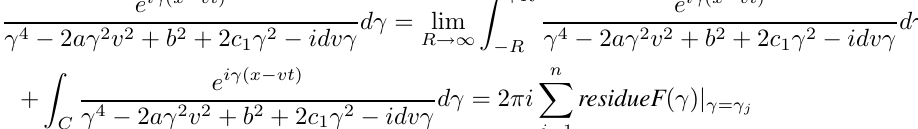
Fig. 2. Position of the poles for damping (a) less than (b) greater than the critical damping. e iγ ( x − vt